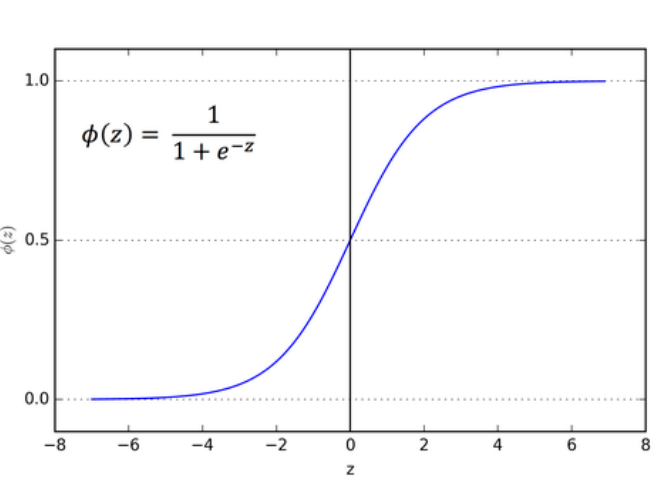
Figure 1. Sigmoid graph. Source: https://towardsdatascience.com/activation-functions-neural- networks-1cbd9f8d91d6 (accessed on 15 October2019). networks-1cbd9f8d91d6 (accessed on 15 October2019).